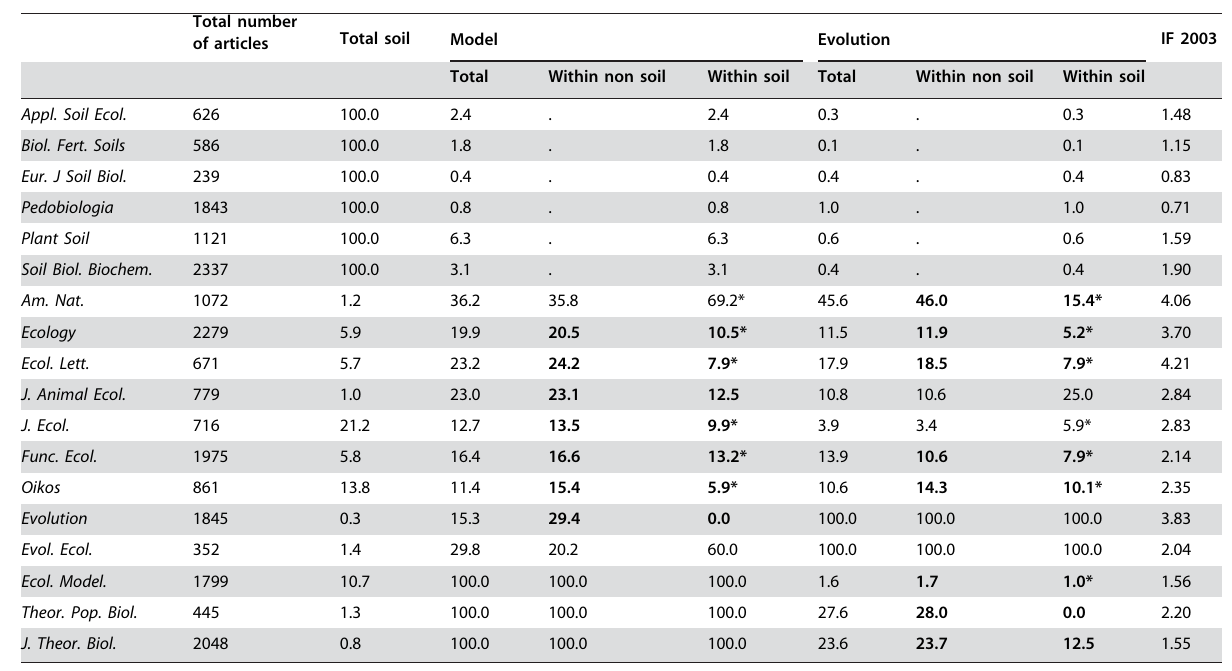
The table gives first the total number of articles examined in each journal, and then the percentages of articles dealing with soil ecology (Total soil), based on modelling (Model), or based on an evolutionary approach (Evolution). In these two latest cases three percentages have been distinguished: total percentages of articles (Total), percentages of articles based on a model or an evolutionary approach within non soil ecology articles (Within non soil) and percentages of articles absed on a model or an evolutionary approach within soil ecology articles (Within soil). Asterisks in the ‘‘Model-Within soil’’ and ‘‘Evolution-Within Soil’’ columns denote a significant difference ( x 2 test, df=1, P , 0.05) between the percentages among all non-soil ecology articles (Within non soil) and soil ecology articles (Within soil). Bold characters denote cases for which a journal publishes more model- or evolution-related articles within its non-soil articles than within its soil articles. Dotes in the ‘‘Model-Within non soil’’ and ‘‘Evolution-Within non soil’’ columns denote the fact that soil ecology journals only publish articles related to soil ecology. Impact Factors (IF) are given for